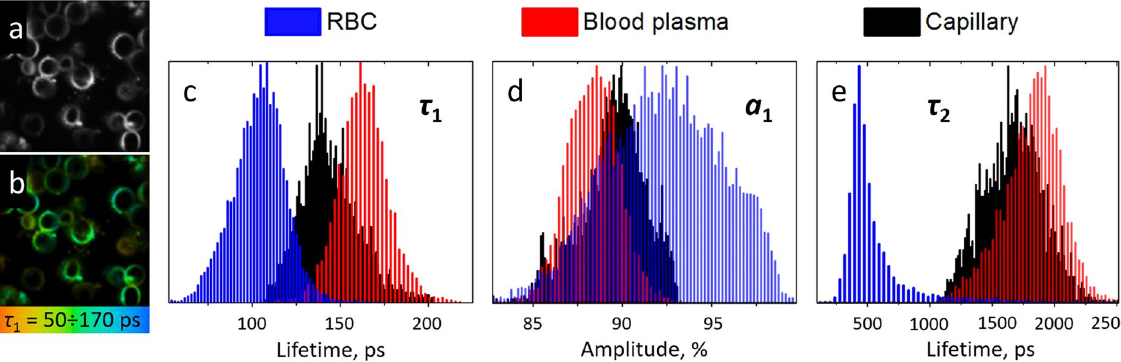
Figure 3. ( a ) TPEAF and ( b ) FLIM images of RBCs obtained at 760 nm excitation (2 mW on the sample, the image width is 50 µ m). The colors in Fig. 3b correspond to the 50–170 ps range for τ 1 , ( c – e ) Normalized distributions of the τ 1 , a 1 and τ 2 parameters obtained for RBCs (blue), blood plasma (red) and capillary (black). The FLIM images were fitted biexponentially for the pixels with maximum intensity exceeding 200